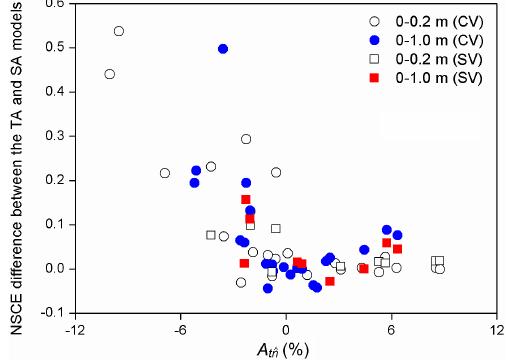
Figure 9. Nash–Sutcliffe coefficient of efficiency (NSCE) differ- ence between the TA and SA models in terms of soil water content estimation using both cross-validation (CV) and split sample vali- dation (SV) as a function of space-invariant temporal anomaly A t ˆ n for (a) 0–0.2 and (b)